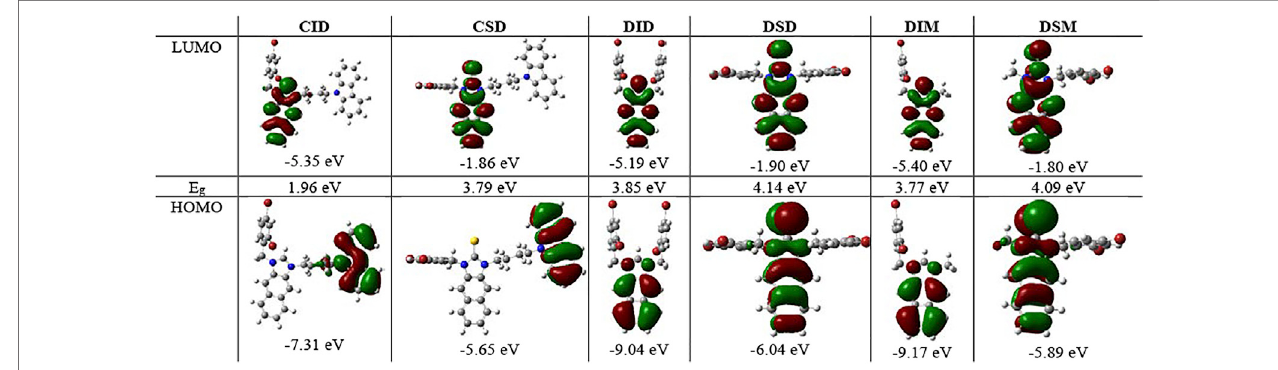
FIGURE 2 | Molecularorbitalsandassociatedenergiesof CID and CSD , DID and DSD , DIM and DSM ,andtheenergygap(E g )betweentheHOMOandtheLUMO.